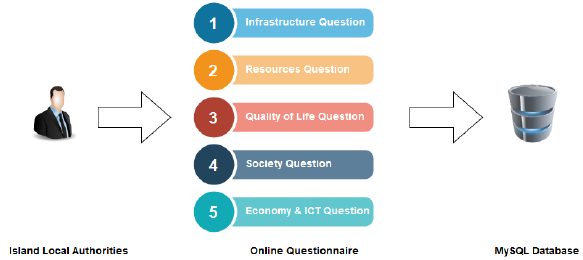
Figure 5. Island local authority data insertion and transfer to the system